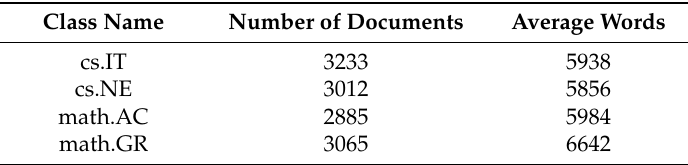
Table 1. Data statistics: #w denotes the number of words (maximum, minimum, and average per